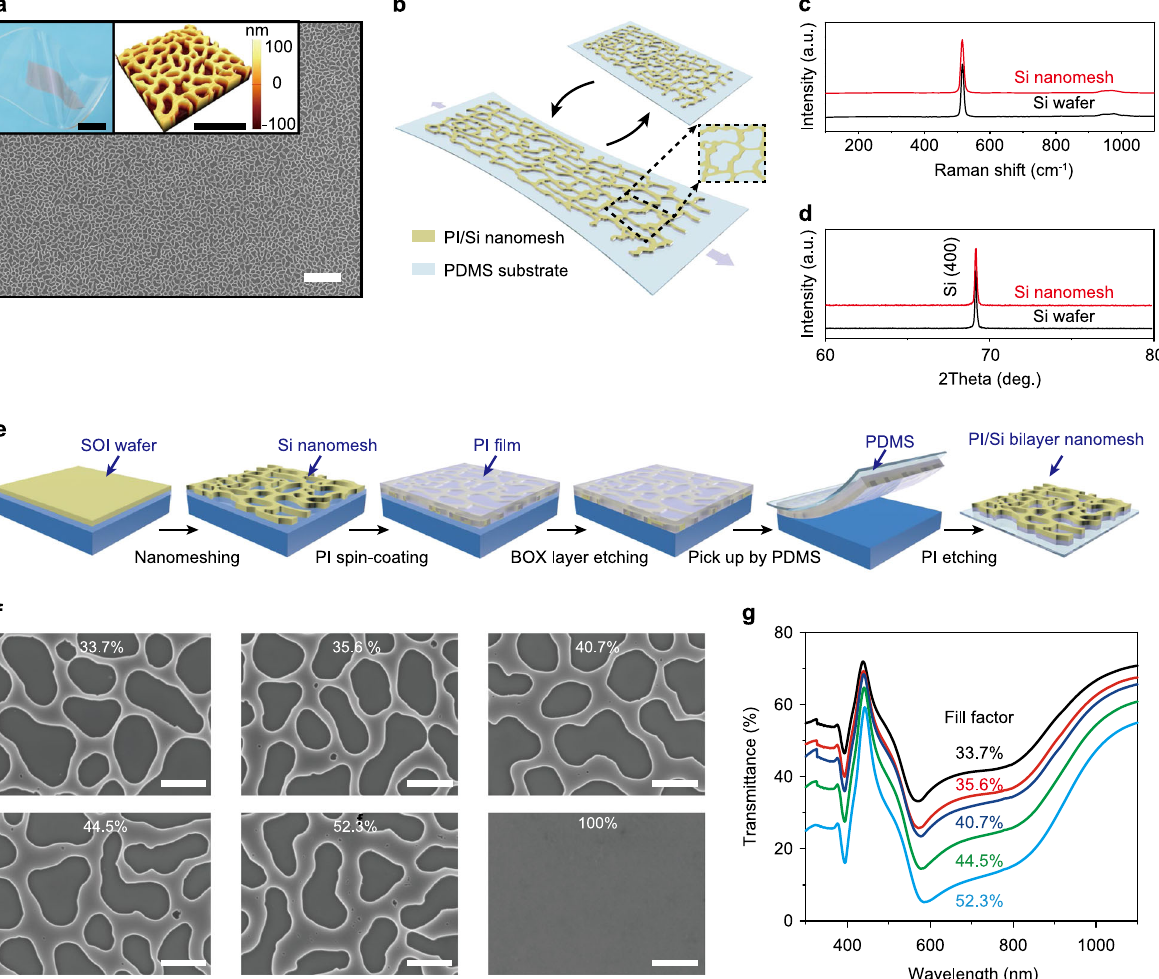
Fig. 1 Materials characterization, fabrication and optical properties of nanomeshed Si nanomembranes. a A scanning electron microscope (SEM) image of a Si-nanomesh fi lm. The left inset is a photograph of the Si-nanomesh fi lm on a twisted PDMS substrate. The right inset is